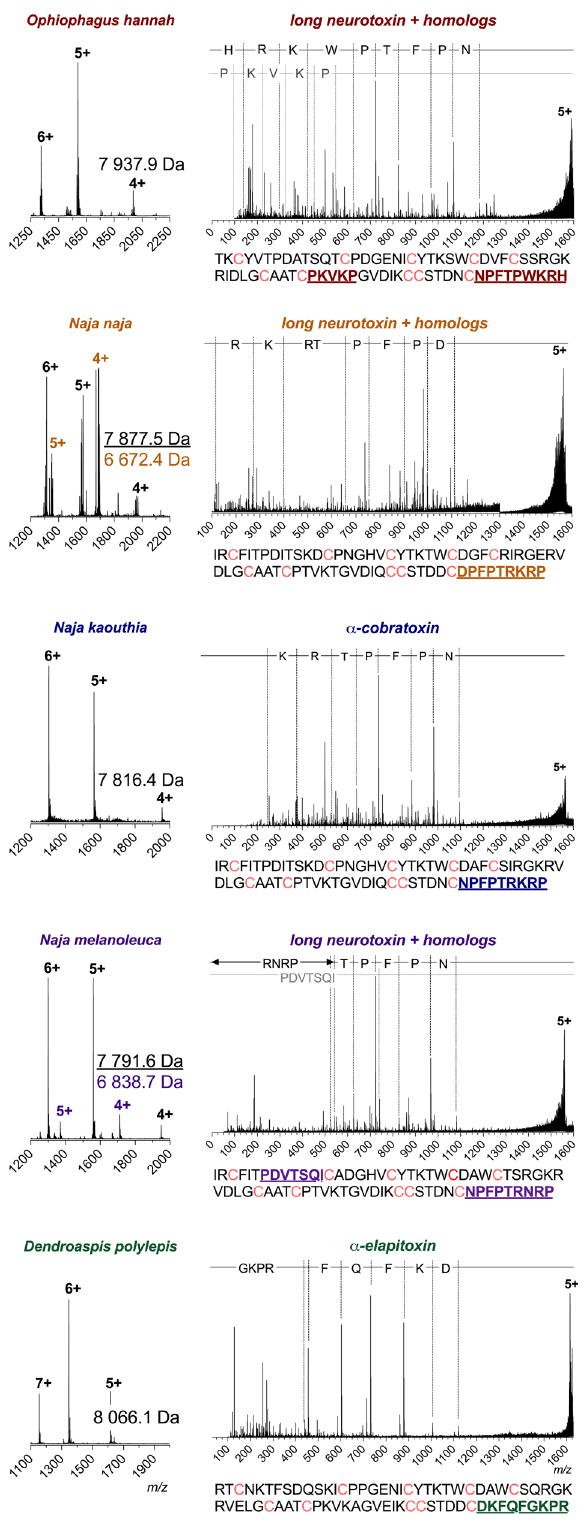
Fig. 2 | Intact masses and top-down sequence analysis of toxins bound by 2554_01_D11. Names above the mass spectra have been color-coded for each species as follows: O. hannah (red), N. naja (orange), N. kaouthia (blue), N. mela- noleuca (purple)and D.polylepis (green).Thespectraontheleft-handsideshowthe charge state distribution for the toxins ejected from the antibody complex by applyingahighconevoltage,wherethemassesoftheidenti fi edtoxinsaregivenin Daltons. The top-down sequence spectra for the most prominent charge state of each toxin are shown on the right-hand side. The difference in m/z is outlined via dotted lines on topand matchesthespeci fi camino acid orpeptide.The fullamino acidsequencefortheproposedidentityofthetoxinsisgivenbeloweachspectrum, with the matching peptides found during the top-down analysis colored and underlined. Cysteines in the sequence are colored